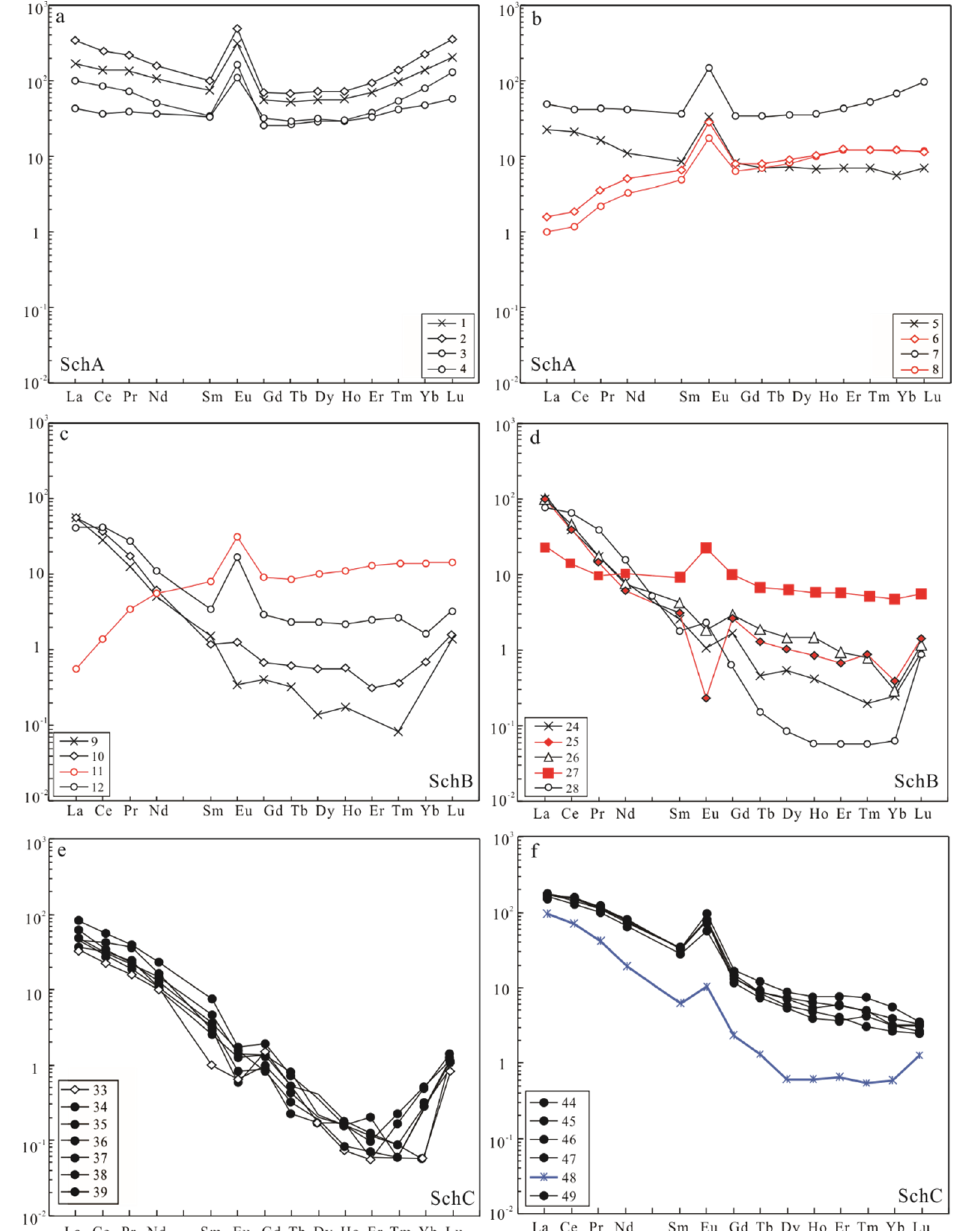
Figure 8. ( a , b ): SchA-higher Σ REE and more predominant positive Eu anomalies; ( c , d ): SchB-obvious different points, and red curves are associated with brighter mantle and rim in SEM-CL images, and these parts in SEM-CL or OM-CL have different optical properties; ( e , f ): SchC-within endoskarn, which mostly have LREE-enriched and HREE-depleted pattern such as bulk rock in porphyry intrusions, and some positive Eu anomalies would probably be caused by fluid. The normalization values were taken from Taylor and McLennan (1985) [33].